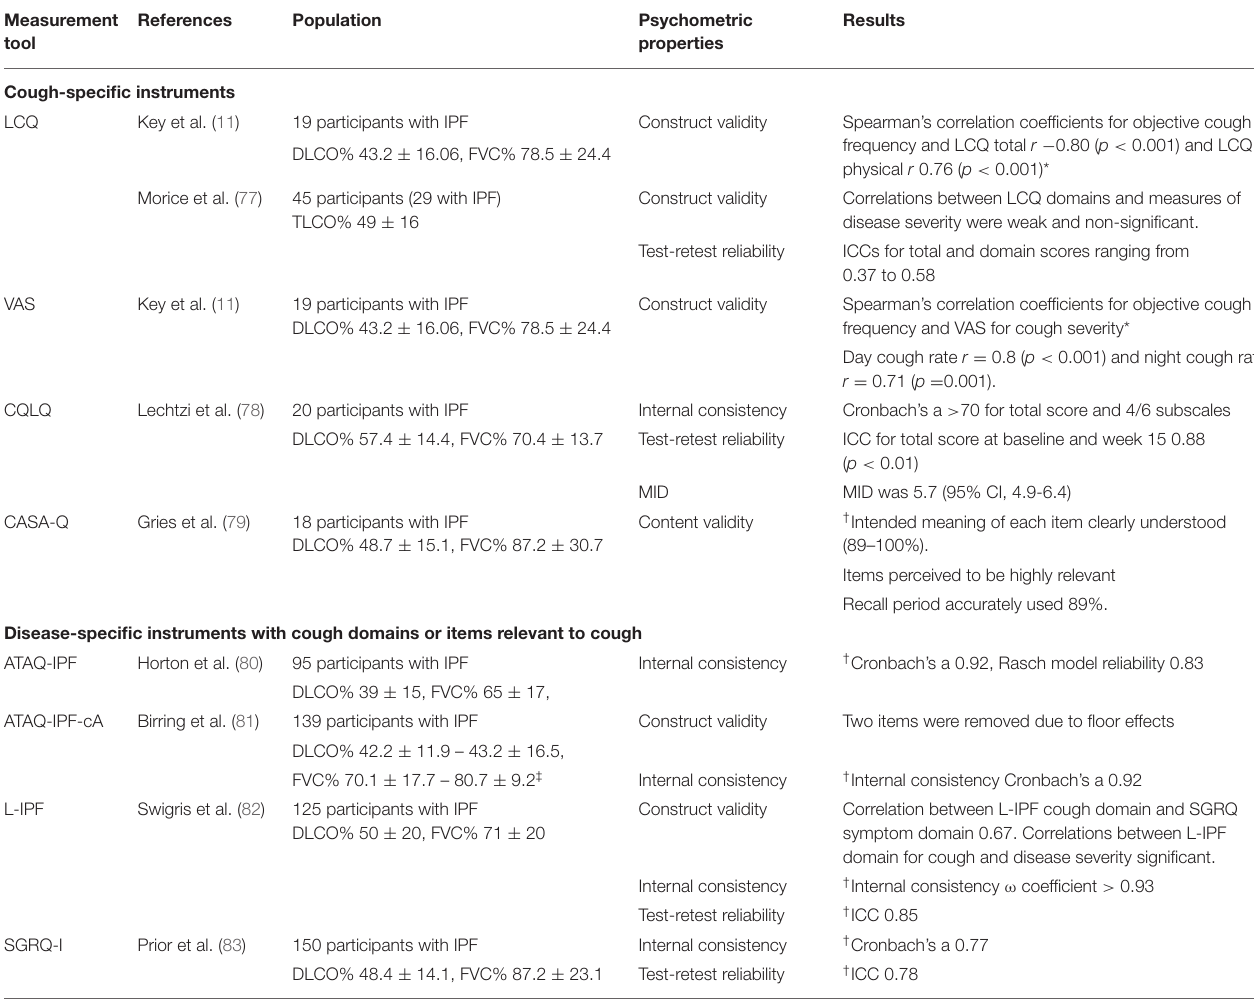
TABLE 2 | Summary of measurement properties of PROMs for cough assessment in IPF. Measurement